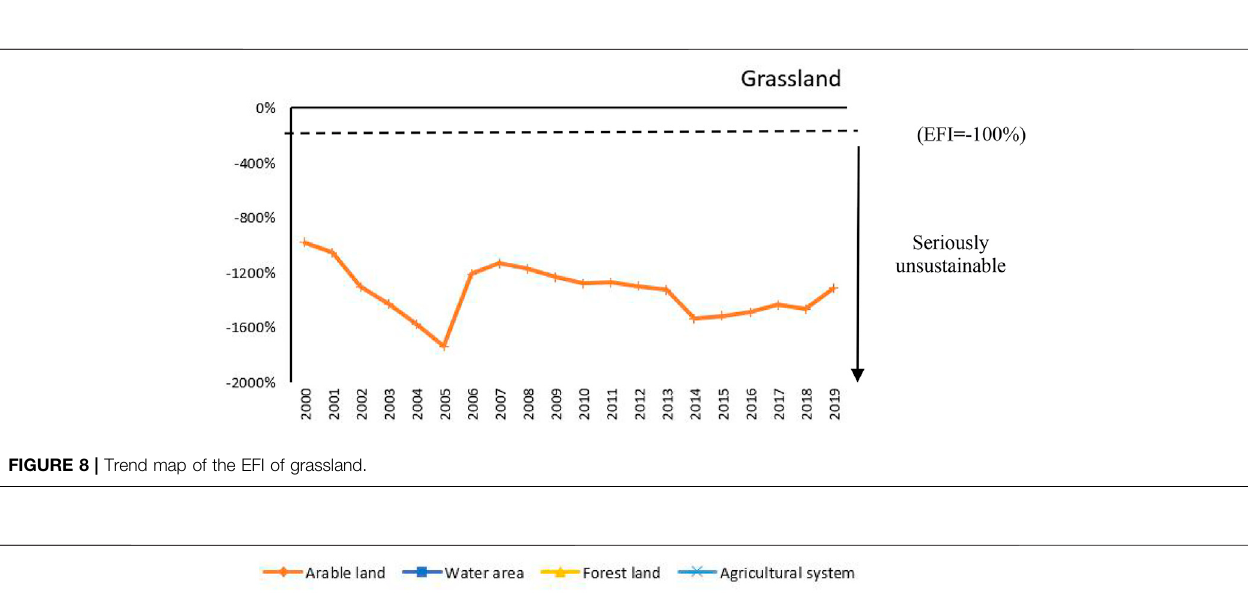
FIGURE 7 | Trend chart of the EFI of arable land, water area, and forest land seriously unsustainable (EFI = − 100%).